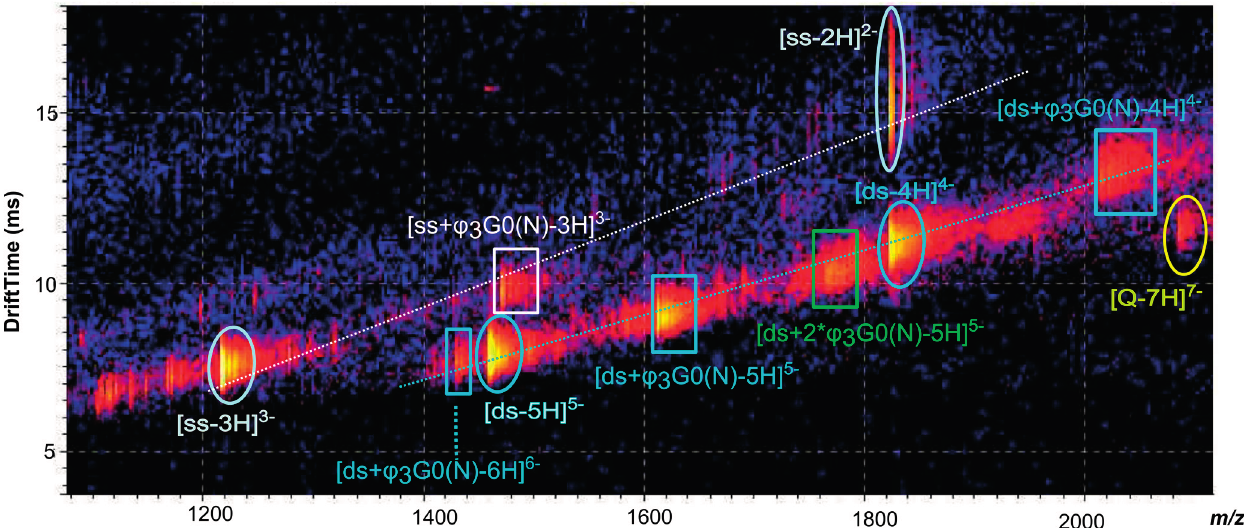
Figure 5. Negative-ion ESI IM-MS plot (drift time vs. m/z ) of [ ds / φ 3 G0(N)] dendriplex in 1:10 molar ratio